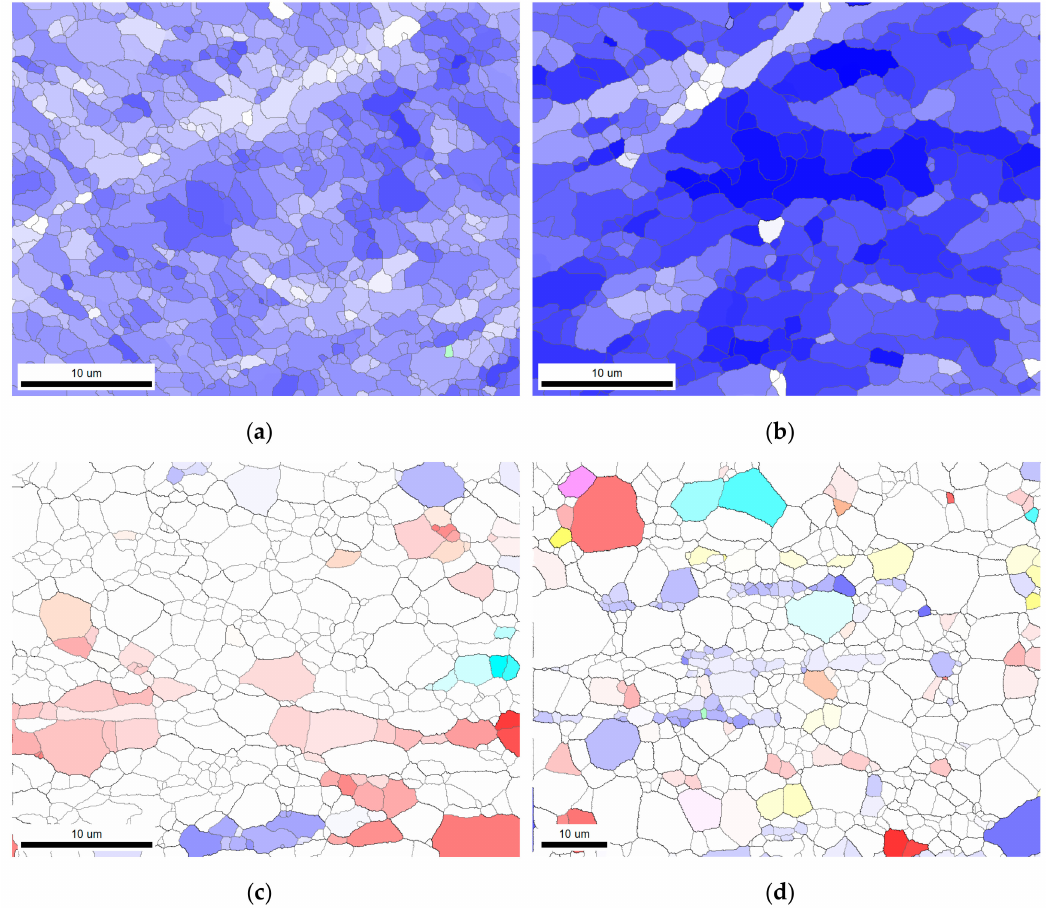
Figure 5. Reconstructed maps of the subgrain structure in HP Al illustrating continuous growth of S-oriented subgrains and the transition from slow to rapid discontinuous growth of near-Cube-oriented subgrains. ( a ) S, as-deformed, ( b ) S, 200 ◦ C, 10 5 s, ( c ) Cube, 220 ◦ C, 10 3 s, ( d ) Cube, 220 ◦ C, 10 5